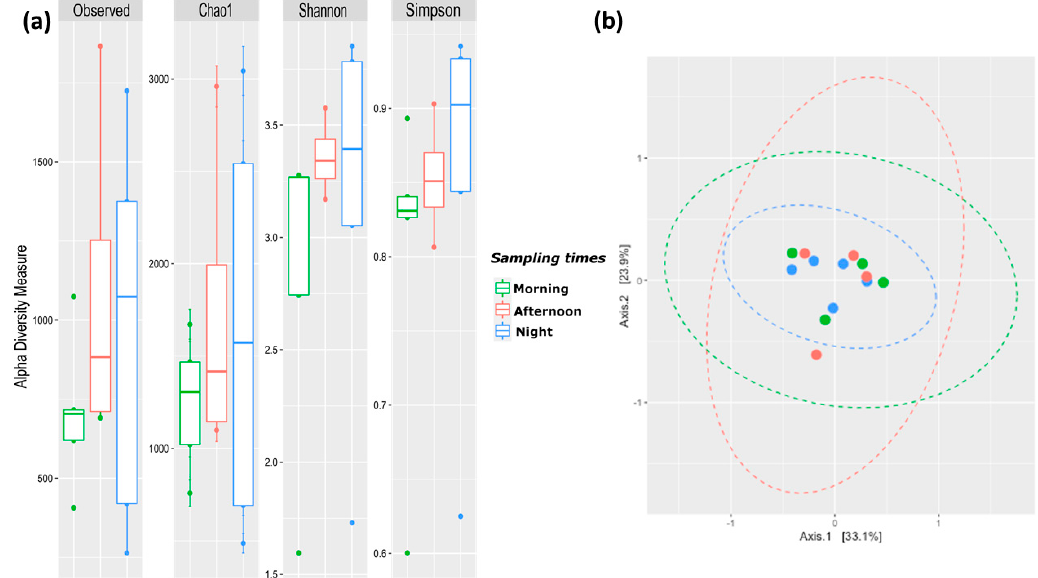
Figure 1. Human milk diversity according to sampling time in the day. ( a ) Alpha diversity indexes based on observed number of species, Chao1, Shannon and Simpson. ( b ) Beta diversity analysis two- dimensional plot calculated with Bray–Curtis test for the human milk samples. Human milk morning samples are plotted as green dots, afternoon samples are represented as red dots and night samples are denoted as blue dots.